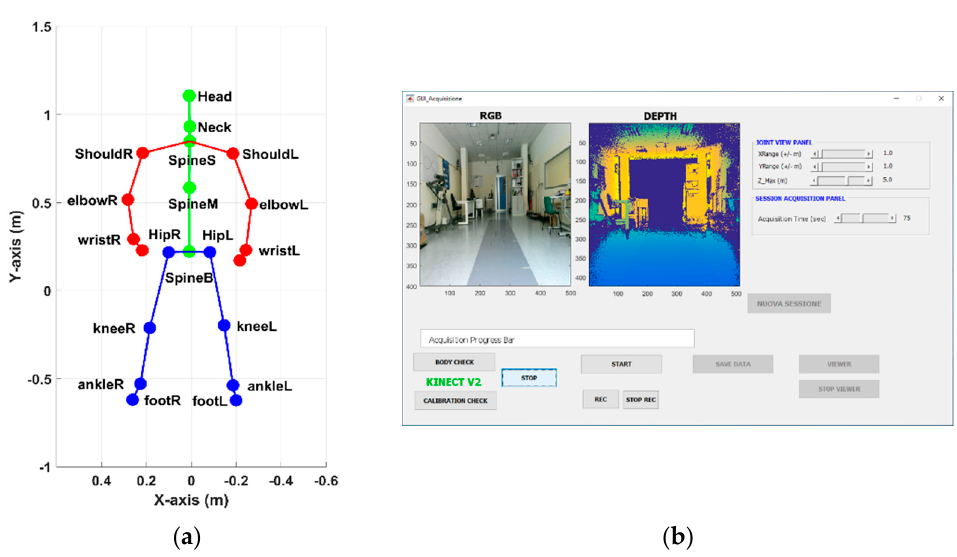
Figure 1. ( a ) Skeletal model and joint positions during the preliminary standing phase; ( b ) main GUI of the acquisition software to control the RGB-D system.